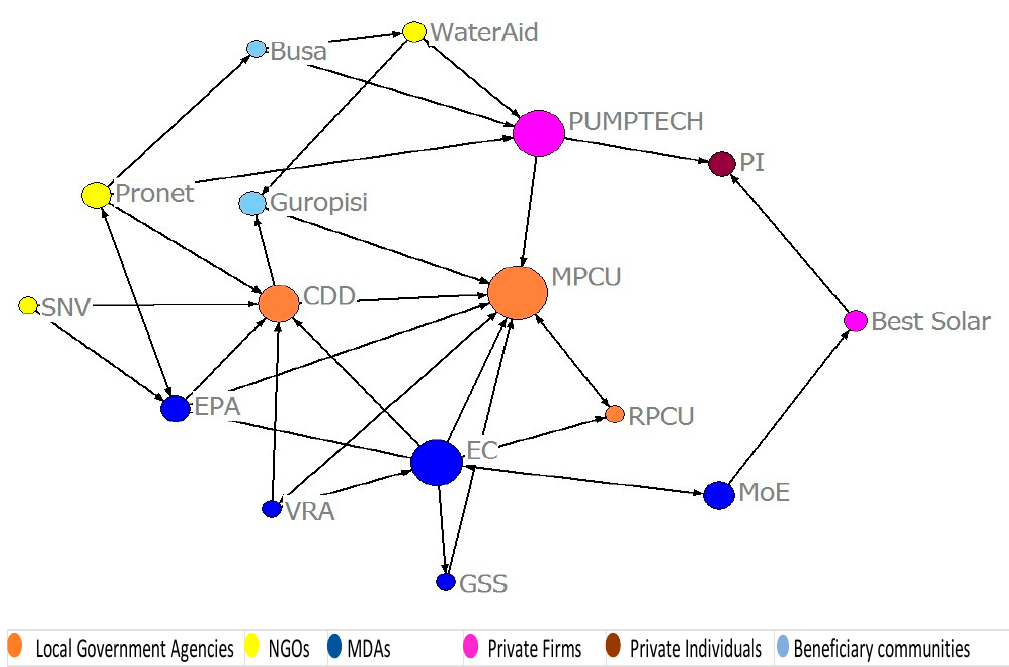
Figure 5. The betweenness centralities of actors in the network (Source: Authors’ conception, created with the NETDRAW component of UCINET 6 [49].